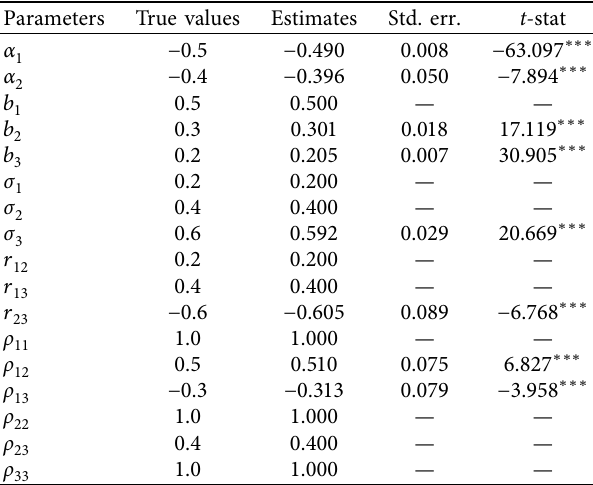
Table 2: Simulation results for a three-alternative MMNP model of 5,000,000 observations when random coefficients are associated with personal